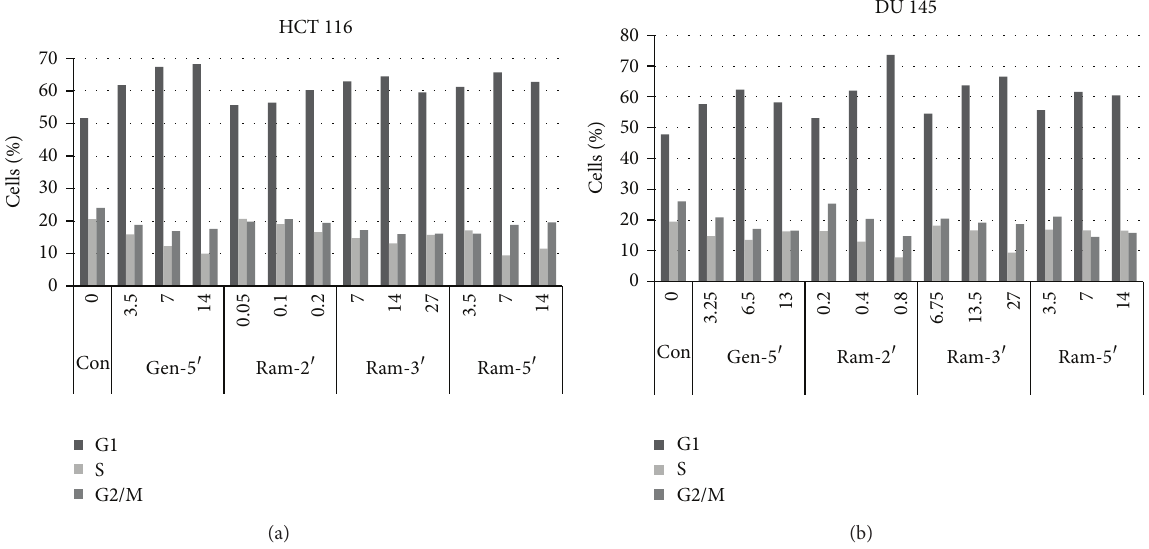
Figure 4: Cell-cycle phases distribution in HCT 116 and DU 145 cells treated with genistein derivatives substituted at C4 󸀠